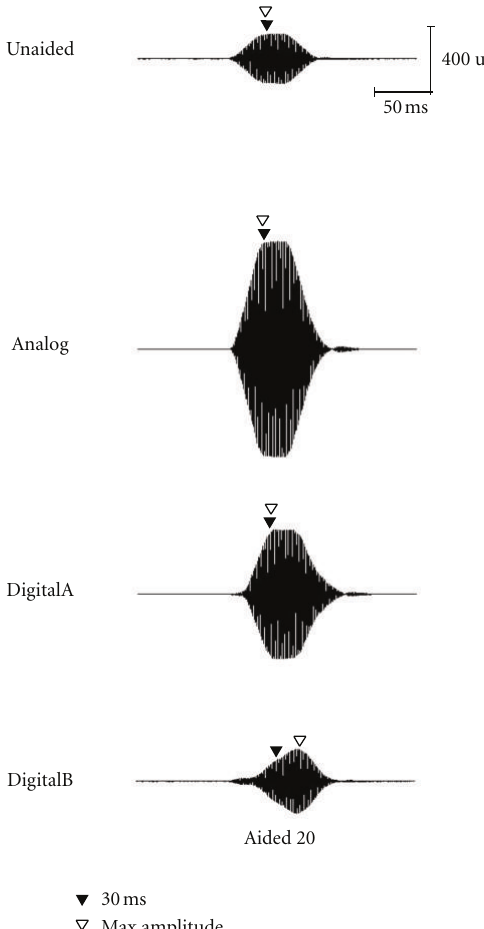
Figure 3: Waveform of the short stimulus presented at 70dB SPL as measured in the ear canal of a single representative subject (subject 2).